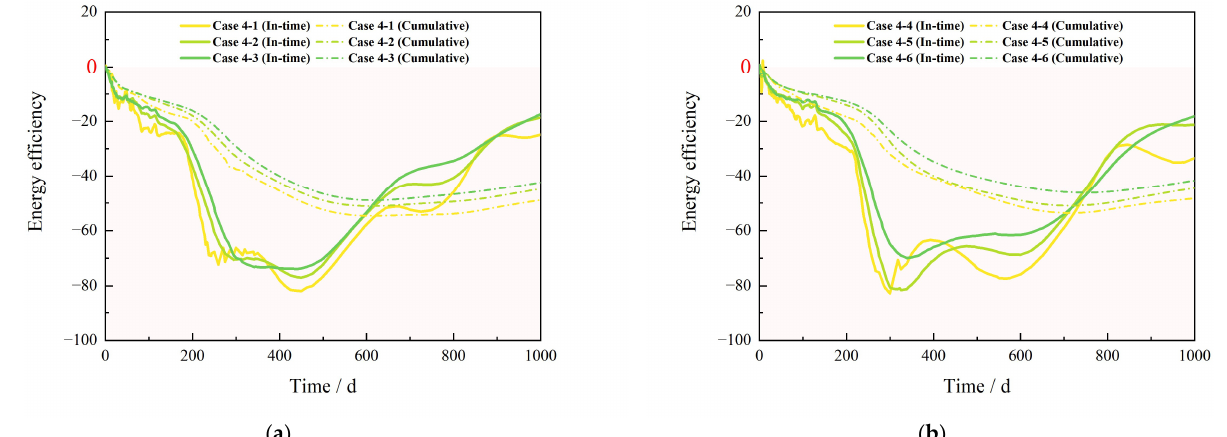
Figure 12. Energy efficiency characteristics for the depressurization combined thermal stimulation: ( a ) P = 1 MPa; ( b ) P = 4 MPa.